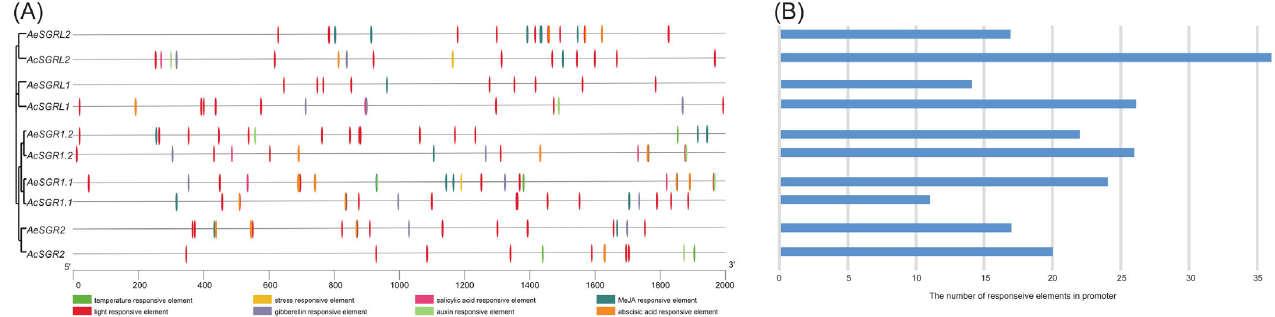
Figure 3. Analysis of cis ‐ acting regulatory elements in the promoter regions of kiwifruit SGR s. ( A ) The distribution of cis ‐ elements in the 2000 bp upstream promoter regions of SGR genes. Different cis ‐ elements are represented by different colors, and ( B ) the number of responsive cis ‐ elements in each SGR gene promoter.